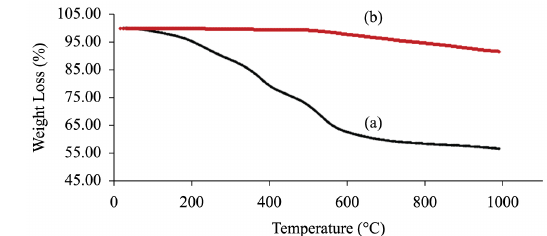
Figure 3. TGA analysis for phenolic resin (a) and TGA analysis for a cured carbon fiber phenolic resin composite